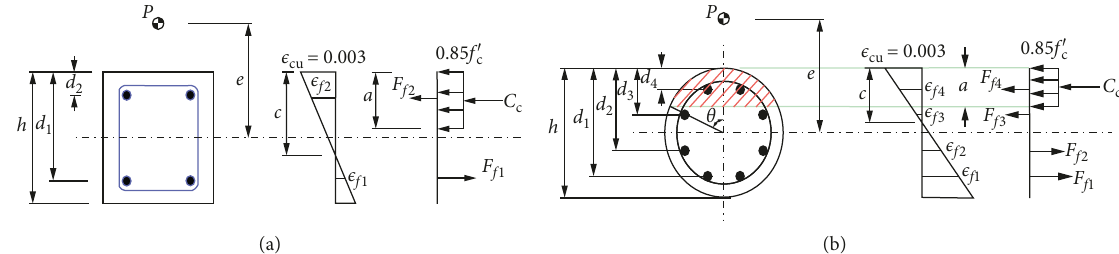
Figure 8: Strain compatibility and force equilibrium of cross section of FRP-reinforced concrete column. (a) Rectangular column. (b) Circular